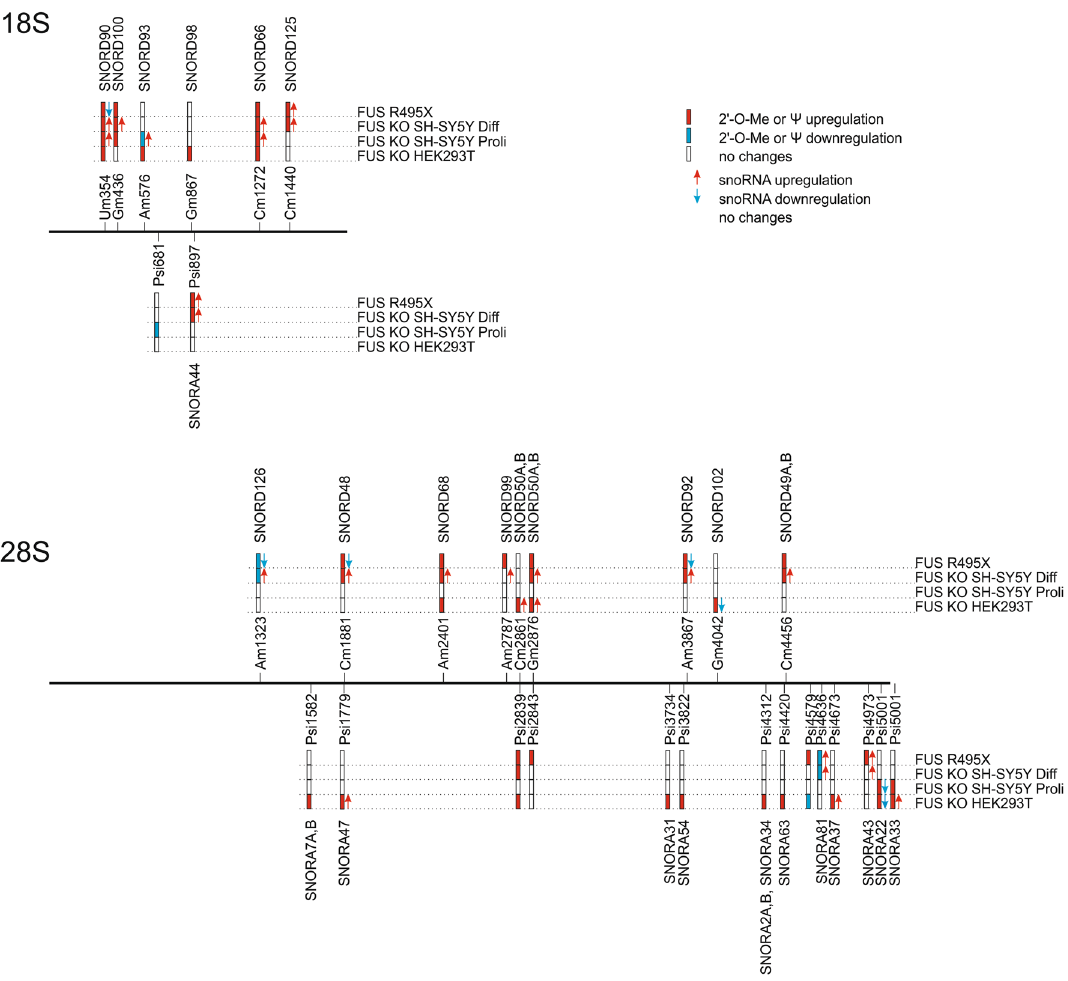
Figure 3. Scheme representing positions in 18S and 28S rRNAs with sites of methylation and pseudouridylation differentially modified in FUS KO and FUS R495X cells in comparison to wild-type cells. Red, blue and white bars indicate upregulation, downregulation or no changes, respectively. snoRNAs responsible for modifications are located above corresponding sites, red and blue arrows indicate snoRNA upregulation or downregulation, respectively, confirmed by small RNA-seq or